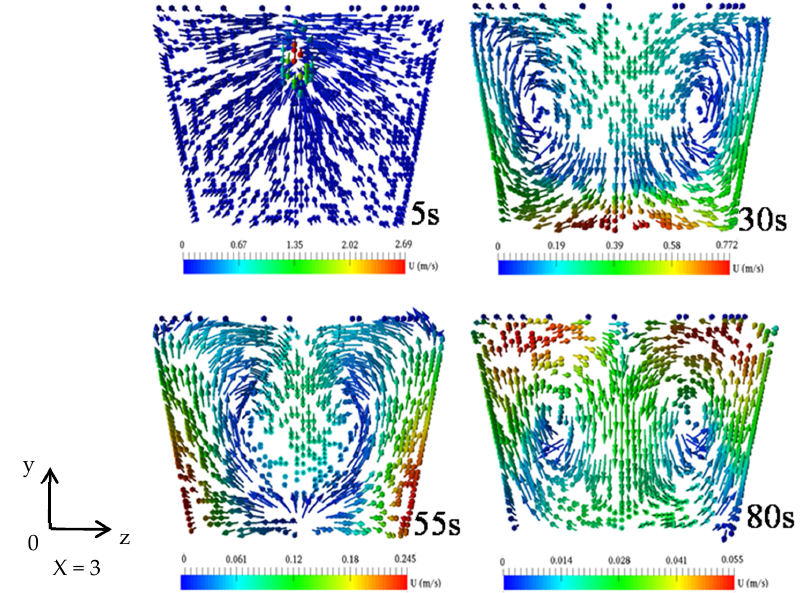
Figure 6. Velocity distribution of the mixture fluid on plane 4 (cf. Figure 3a) at 5, 30, 55 and 80 s.